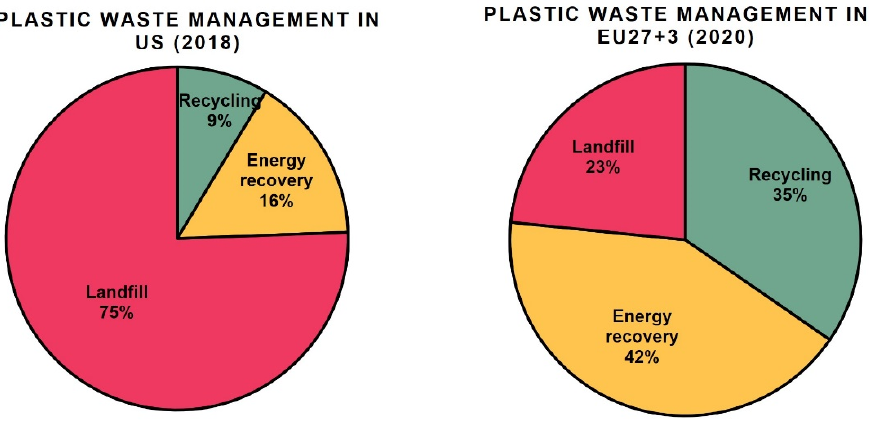
Figure 2. Post-consumer plastic waste management in US (2018) and EU27+3 (2020). The figure is created according to the data from US EPA [2] and PlasticsEurope [3].